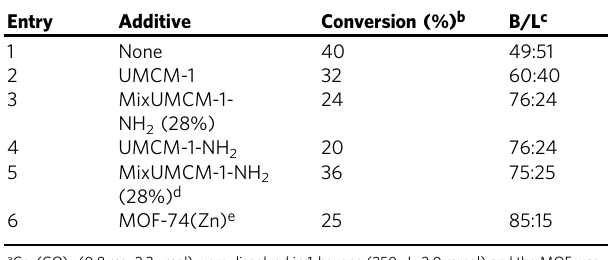
a Co 2 (CO) 8 (0.8mg, 2.3 µ mol) weredissolved in1-hexene (250 µ L, 2.0mmol)andthe MOFwas added (mol MOF /mol Co = 1.7); the mixture was brought to 30bar and 100°C for 17h. b The fi nal reaction mixture contained 1-hexene, 1 , 2 , n -heptanale and unknown compounds (~2%) as detected by GC-FID and GC-MS. c 1:2 ratio = 3:1. d mol MOF /mol Co = 0.8. e mol MOF /mol Co =